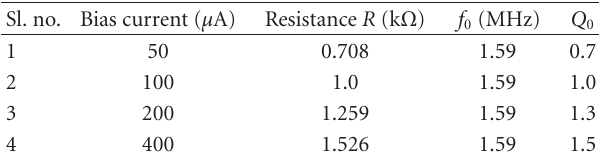
Table 7: Component values for orthogonal adjustment of Q with f 0 .